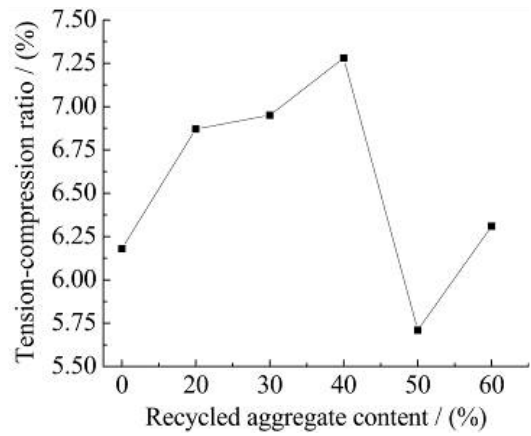
Figure 4. Tension and compression ratio.